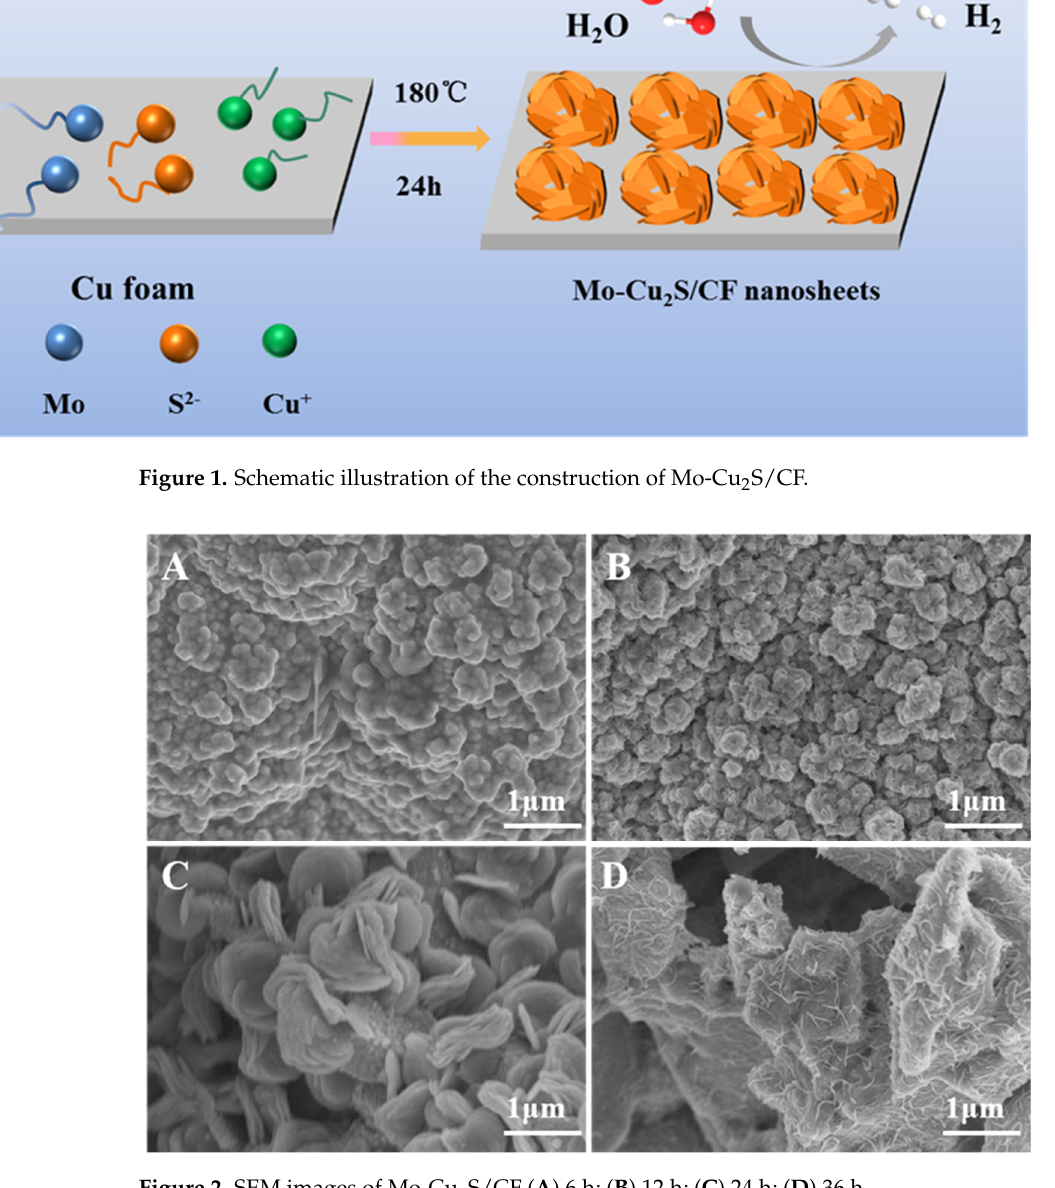
Figure 2. SEM images of Mo-Cu2S/CF ( A ) 6 h; ( B ) 12 h; ( C ) 24 h; ( D ) 36 h.